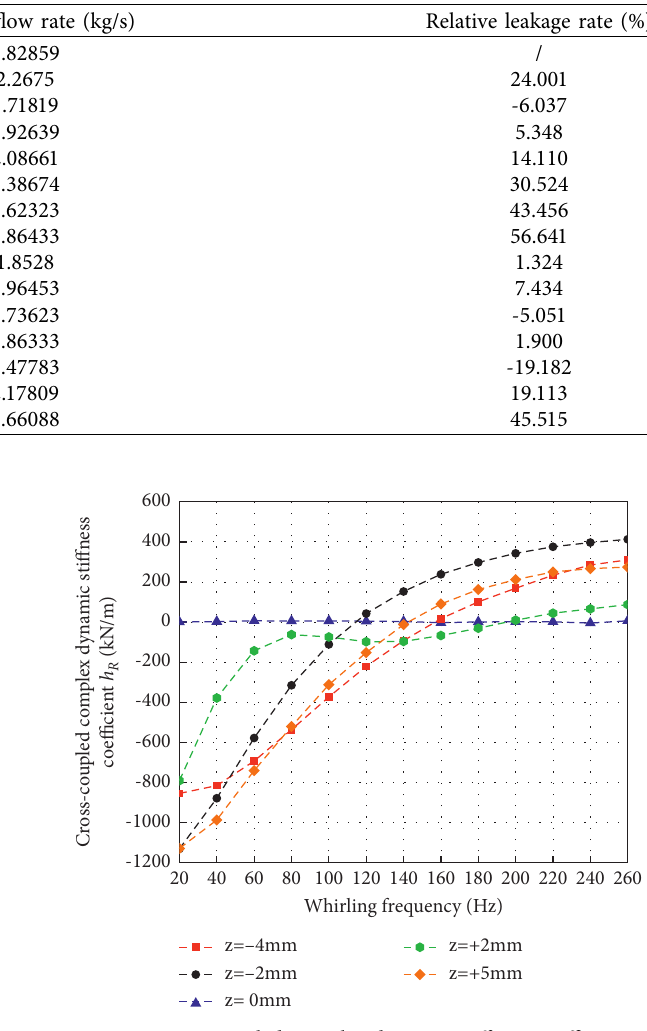
Table 4: Comparison of leakage flow rate under various calculation conditions.